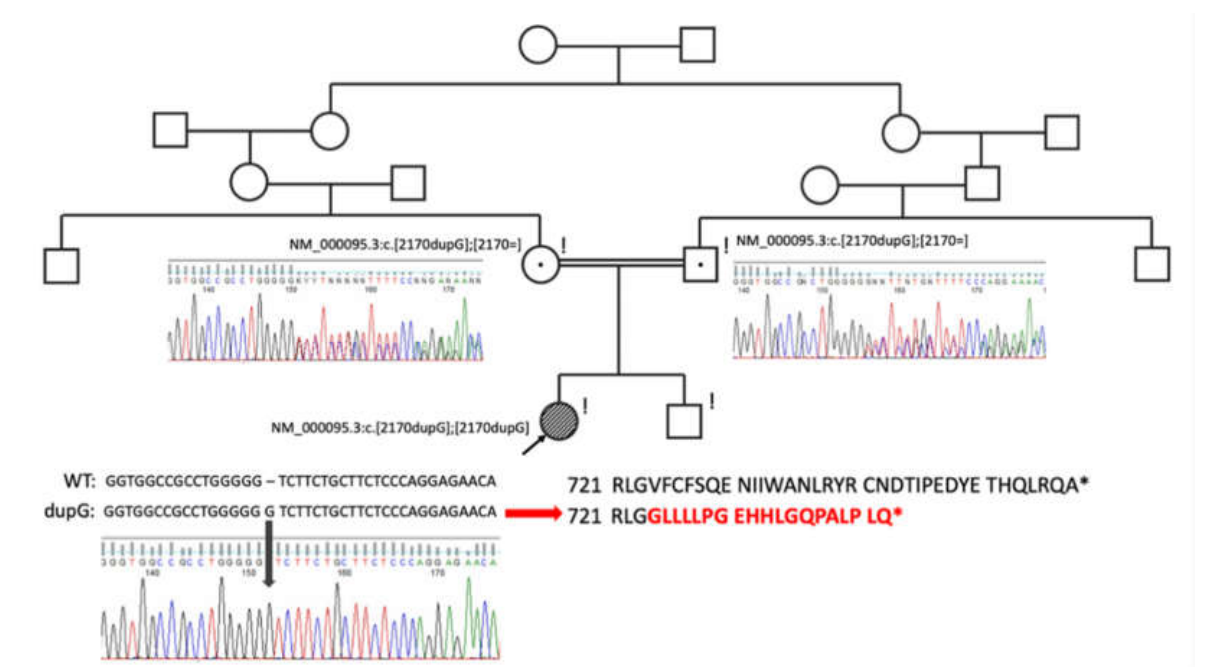
Figure 4. A novel homozygous frameshift variant that disrupts the sequence of 35 amino acid residues in the C-terminal domain of the COMP: c.2170dupG (p.Val724Glyfs*20) was identified in the proband. Segregation analysis of this variant in the family confirmed its presence in the heterozy- gous state in the parents.